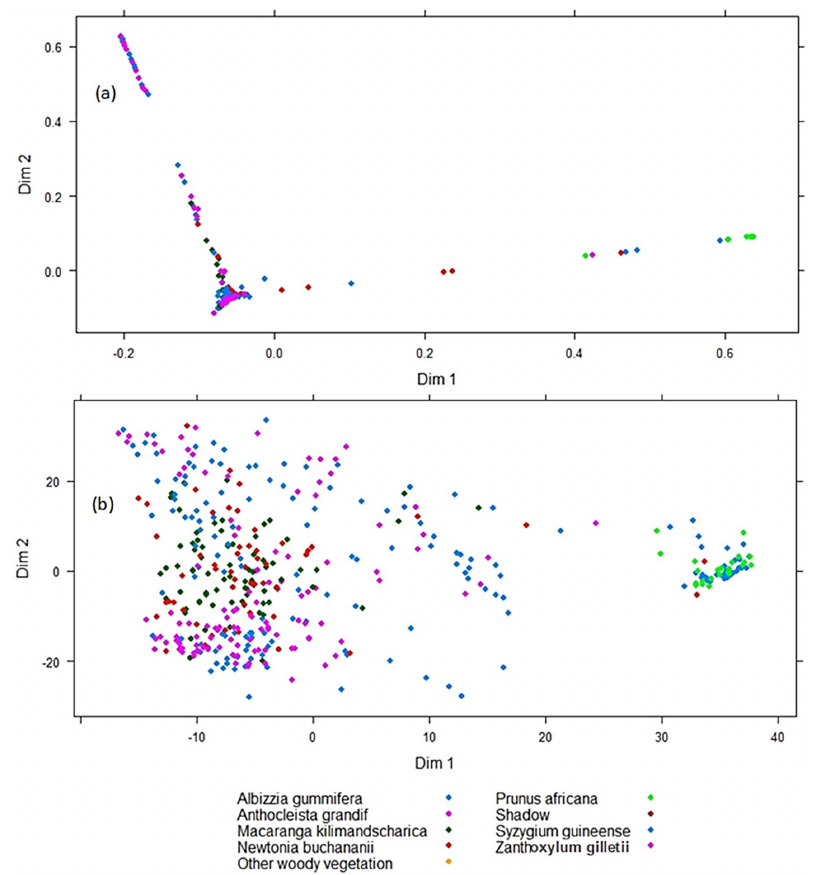
Figure 8. Visualizing tree species (dis)similarity using MDS scaling: ( a ) RF; ( b ) SVM. The confusion matrices in Table 4 are for RF and SVM classifiers, for the combined technique, and F1 ‐ scores were closest to their model mean. They were computed using the test data, which comprised 30% of the ground truth data.